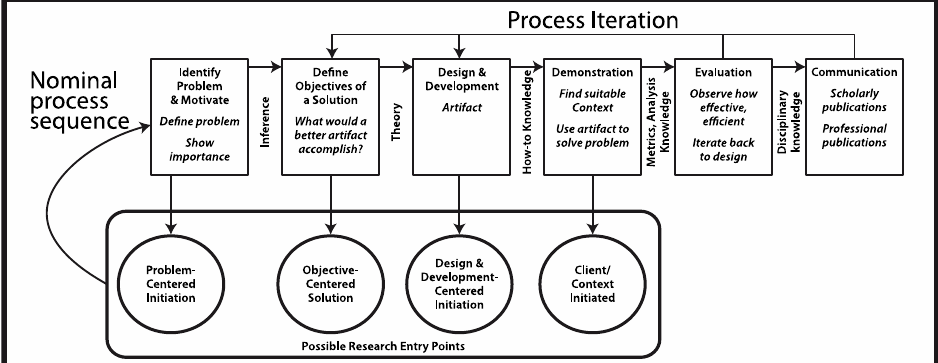
Figure 1. Design science research method [18].